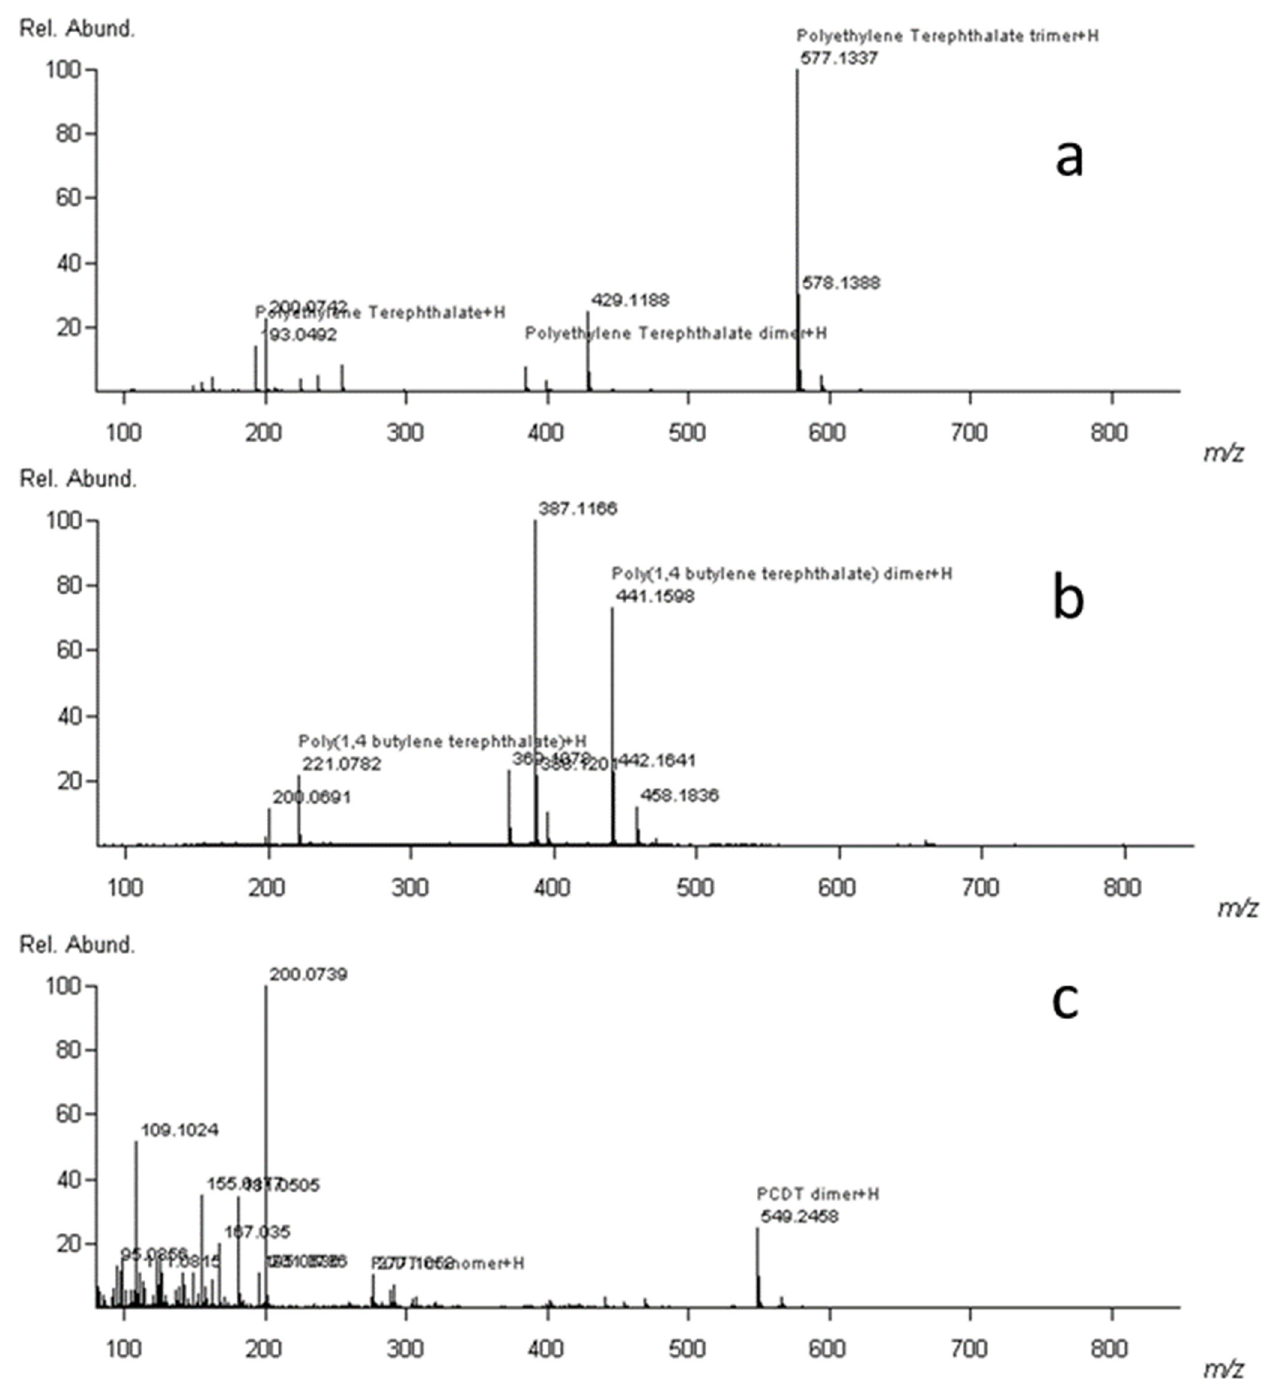
Figure 6. DART-AccuTOF ™ mass spectra for standards ( a ) PET, ( b ) PBT, and ( c ) PCDT at 30 volts with correct peaks identified using SearchFromList software.